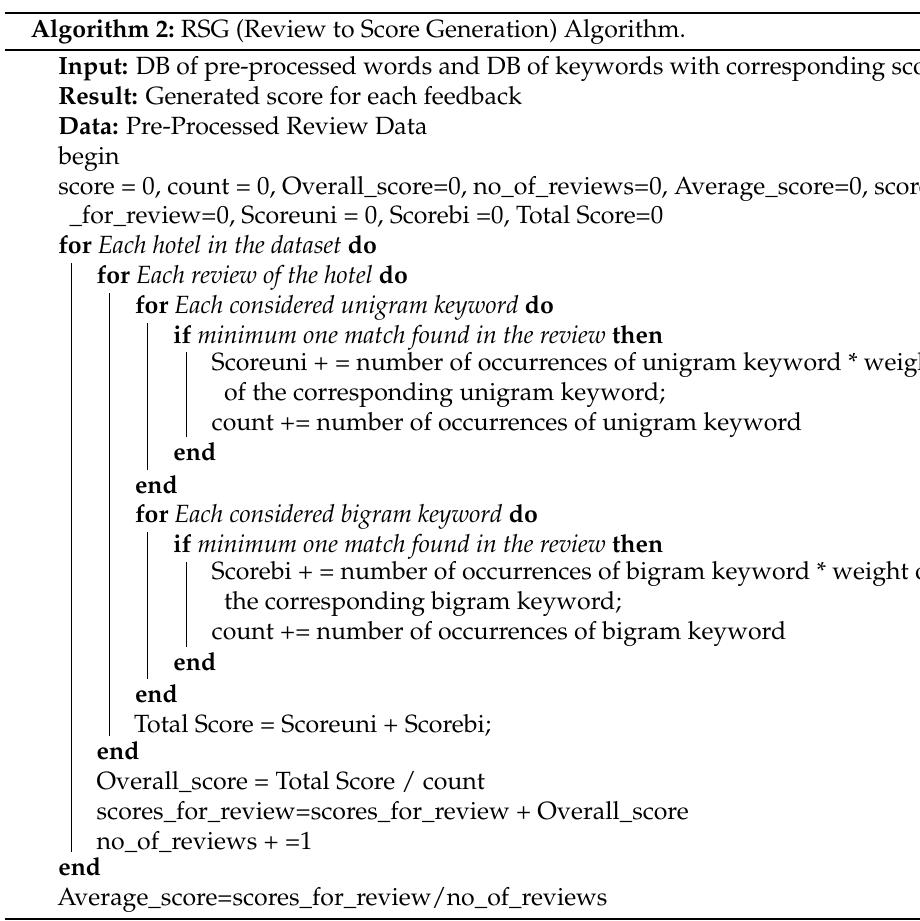
Algorithm 2: RSG (Review to Score Generation)